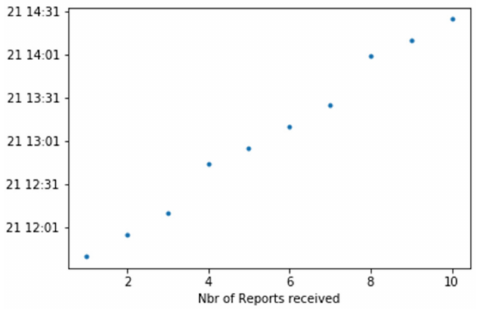
Figure 9. Number of files actually received as a function of time–12 smart meters.